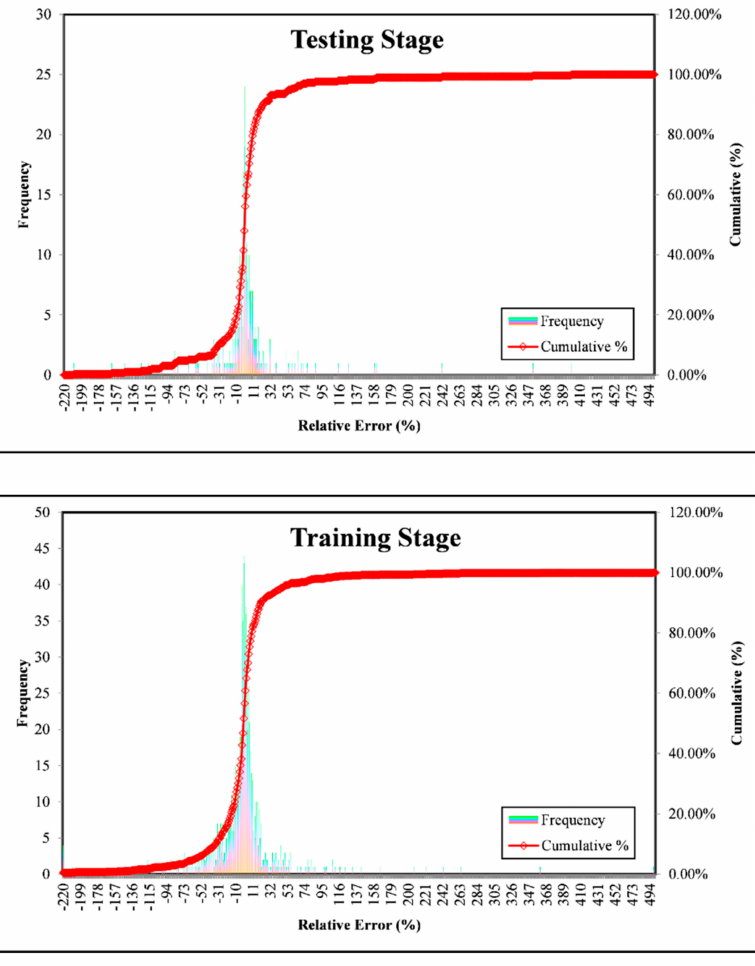
Figure 6. Histogram diagram of relative